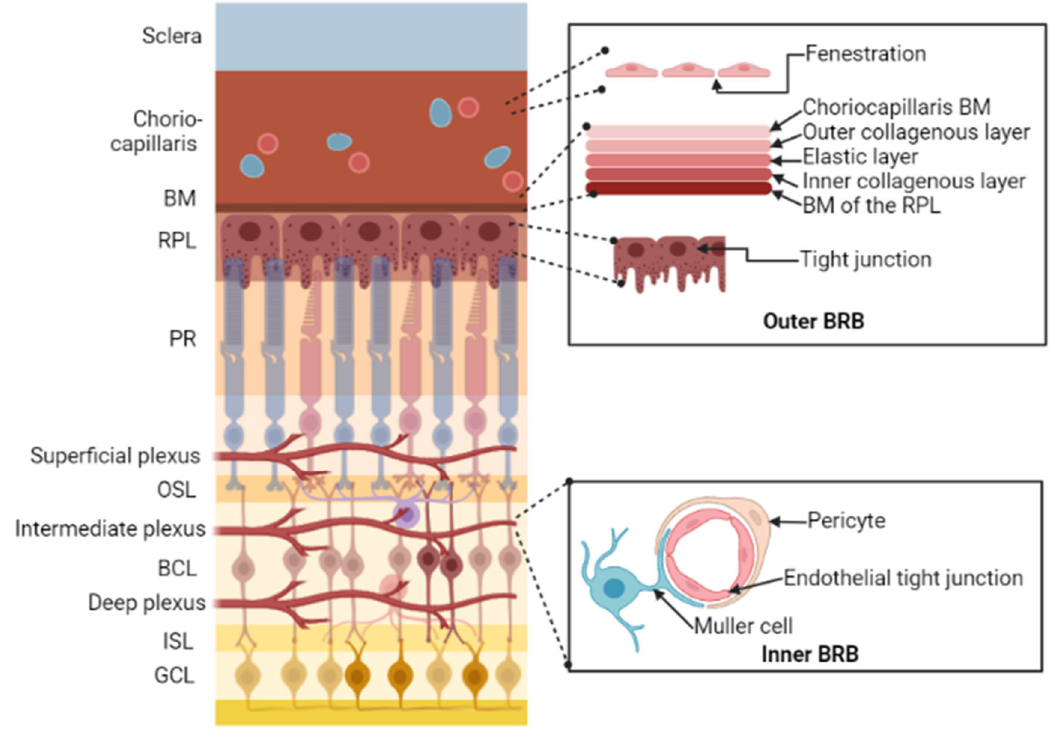
Figure 1. Schematic drawing of the blood ‐ retinal barrier (BRB) structure. The outer BRB protects the outer retina from circulation derived from choriocapillaris, which has numerous fenestrations in its endothelium. Drug molecules enter the neuroretina through a five ‐ layer structure called Bruch’s Membrane (BM), that provides a size ‐ selective barrier and the retinal pigment layer (RPL), which is characterized by tight connections. The inner BRB protects inner retina from the retinal vasculature, which consists of a deep, intermediate, and superficial plexus; the endothelial cells of the retinal arteries constitute an efficient barrier due to the existence of tight connections among them [12]. PR, Photoreceptor; OSL, Outer Synaptic layer; BCL, Bipolar cell layer; ISL, Internal Synaptic layer; GCL, Ganglion cell layer. Image was created in